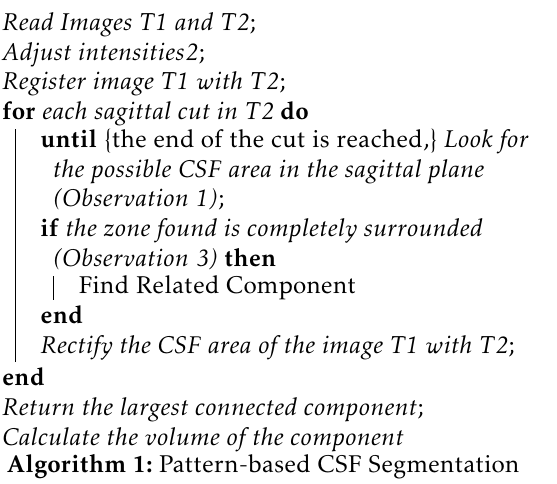
as correct. In the case of medical image segmentation, image databases (synthetic or in vivo), segmentation of other techniques, manual segmentation performed by a specialist, etc., are used for comparison. For metallographic images, data obtained from an ISO